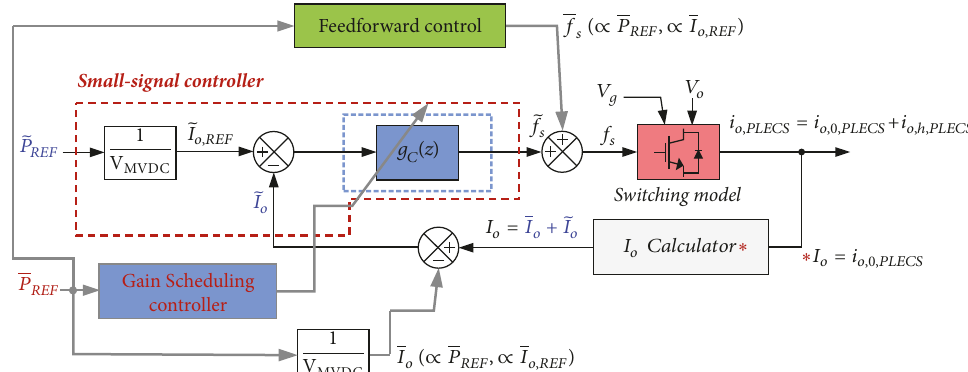
Figure 9: Control block of the series resonant converter SRC# in z-domain.